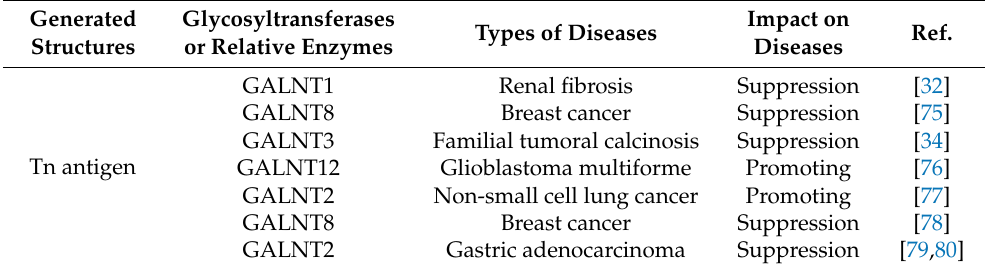
Table 1. The roles of glycosyltransferases and relative enzymes in different diseases involved in the